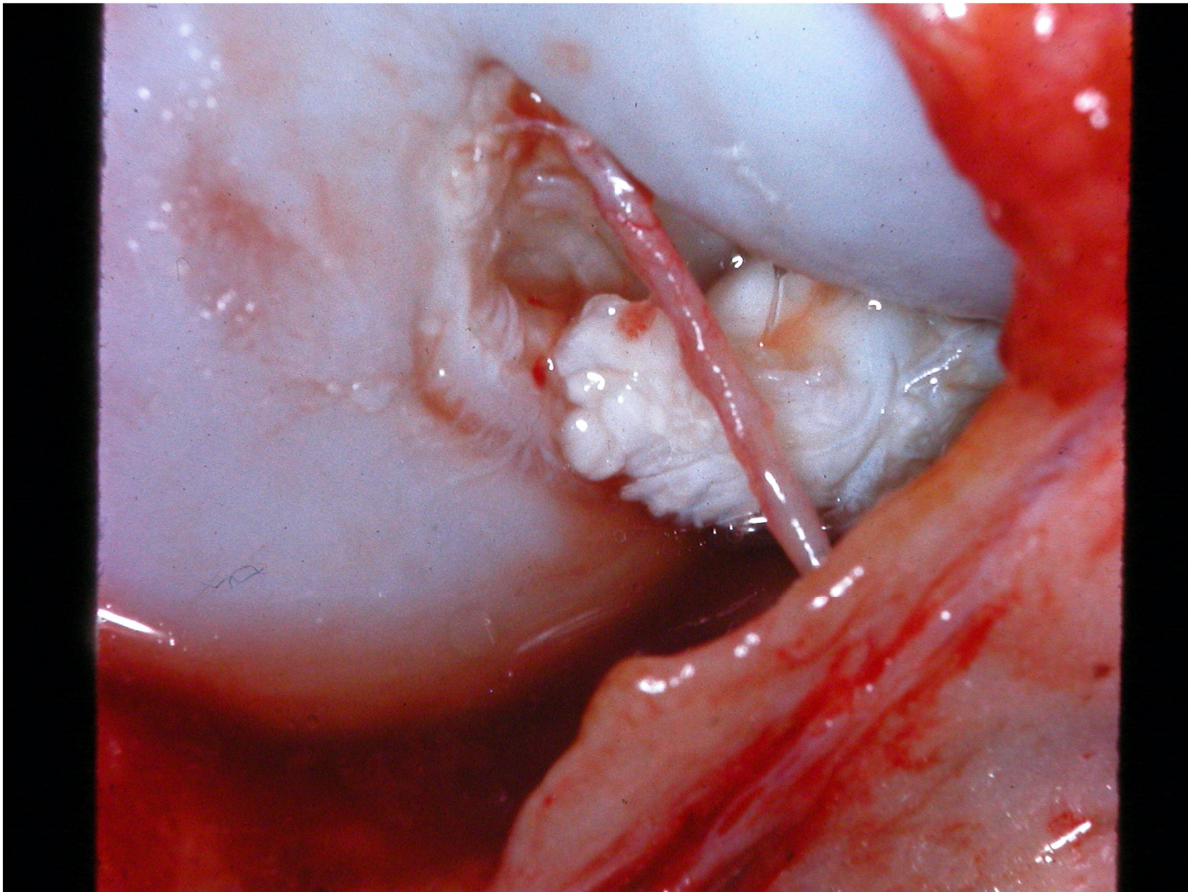
Figure 2. Intra-operative image of a cranial cruciate ligament ruptured 4 weeks previously; note the distal ligament stump with rounded fibrillar edges due to ongoing collagenolysis; surface is partly covered by an inflammatory tissue membrane (reddish patches). The structure visible in front of the ligament is the remnant of the epiligamentous synovial shield which covered the intact cruciate ligament (image by the author).